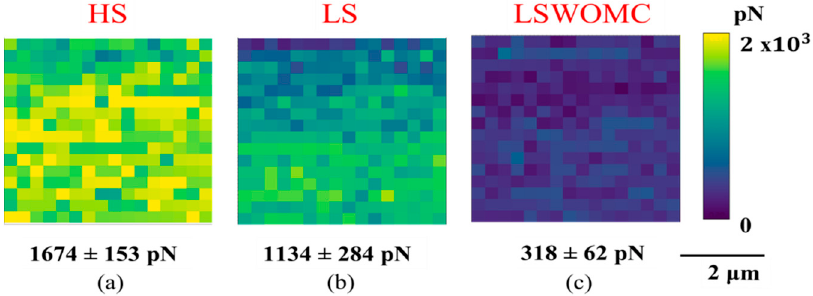
Figure 6. Force volume maps collected over a 5 µ m × 5 µ m scan area characterizing the adhesion of non-polar -CH 3 group to mica substrates in ( a ) HS, ( b ) LS and ( c ) LSWOMC brine solutions. The mean adhesion force beneath the 16 × 16-pixel maps was based on 256 force curve measurements. A reduction in the salt concentration from HS to LS led to a decrease in the adhesion force (left to right). Reducing the concentration of Ca 2 + and Mg 2 + to zero while maintaining same amount of TDS as LS (LSWOMC) also lowered adhesion force significantly.